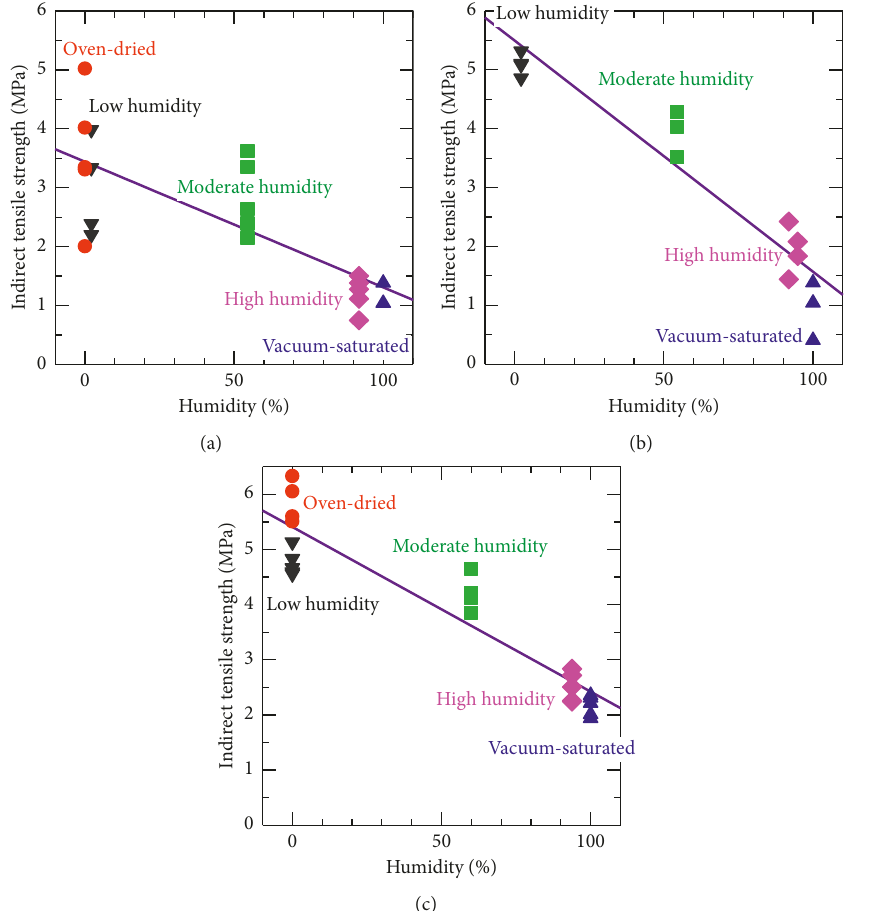
Figure 13: Indirect tensile strength variation against humidity. (a) Mchenga arkose sandstone. (b) Mchenga fine-grained sandstone. (c) Kimachi sandstone. Table 2: Coefficients in equation (3) for three types of rocks. Constants Rock A T (MPa) B T (–)